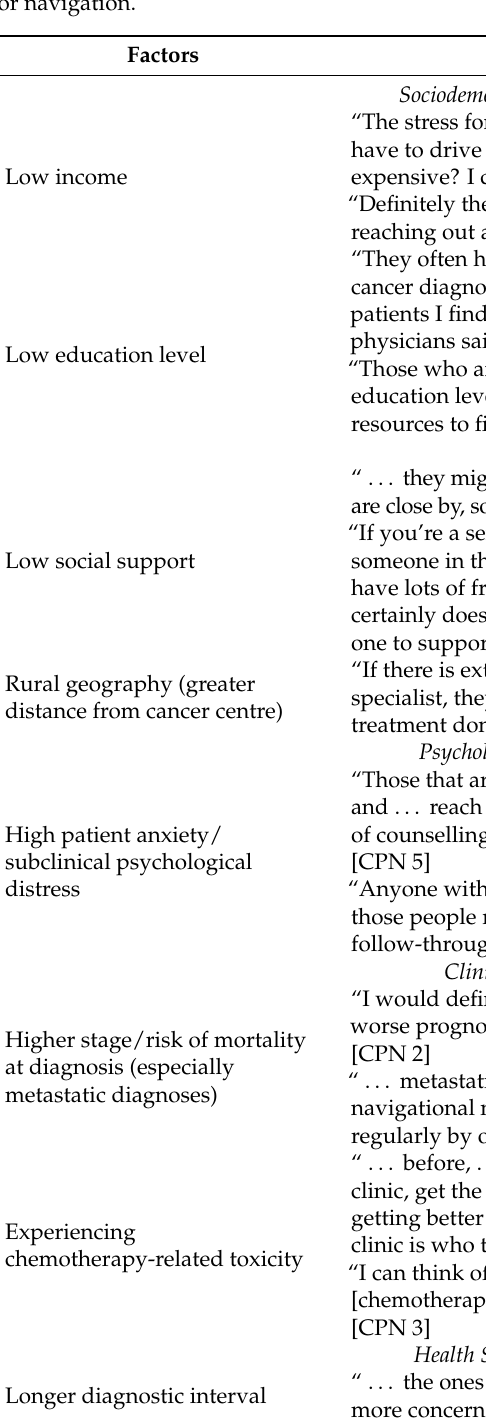
Table 3. Supporting CPN interview quotes for selected factors associated with a greater need for